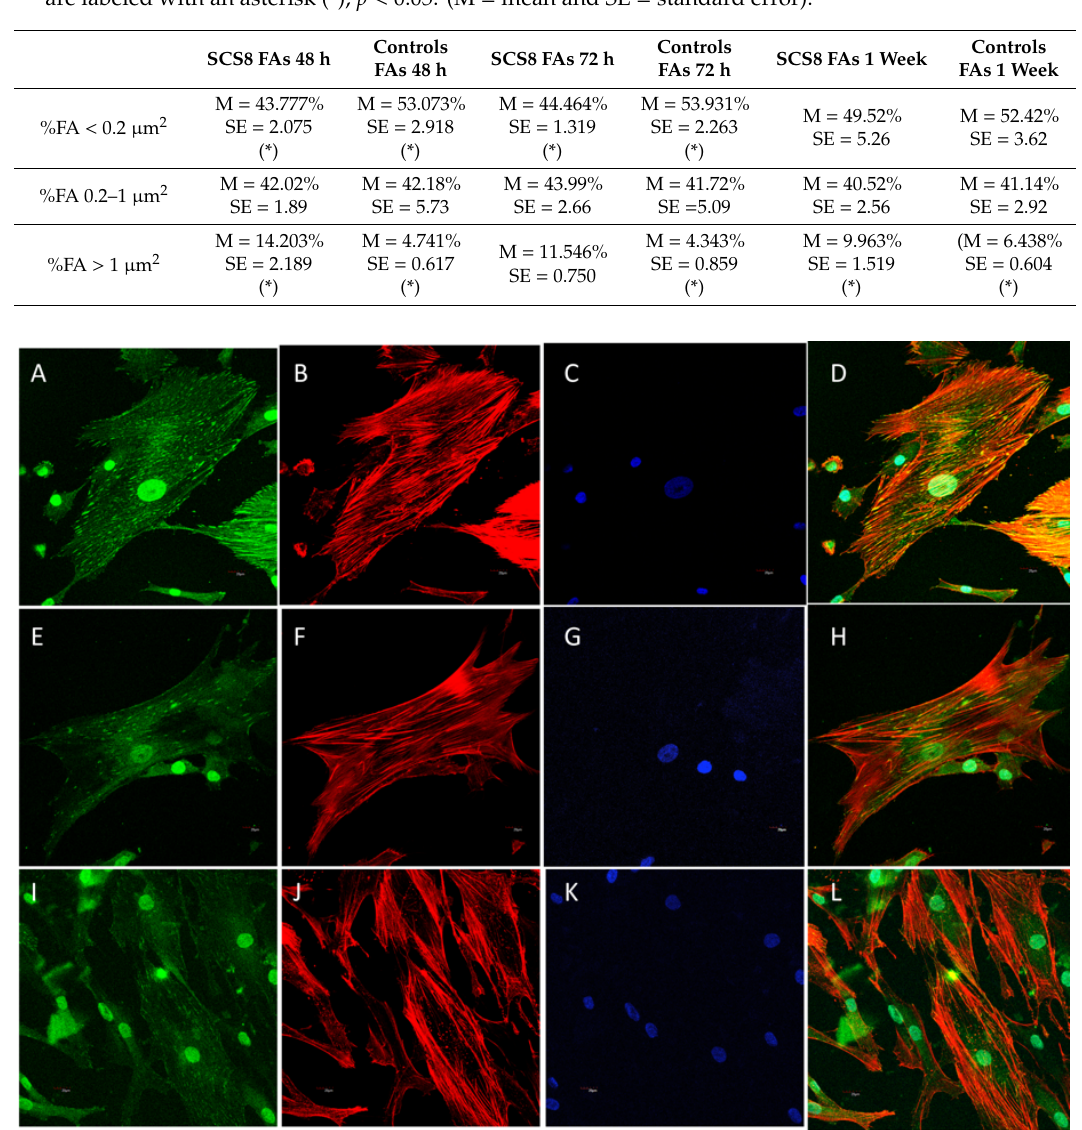
Figure 13. Representative images of HOB ® cells grown on SCS8 aerogel and immunolabeled for actin cytoskeleton (rhodamine-phalloidine, red) and focal adhesion development (vinculin, green). Nuclei are identified with DAPI. Cells immunolabeled after 48 h in culture ( A – D ); 72 h in culture ( E – H ); 1 week ( I – L ). Table 5. Percentage of focal adhesions compared by size and time. Statistically significant differences are labeled with an asterisk (*), p < 0.05. (M = mean and SE = standard error).